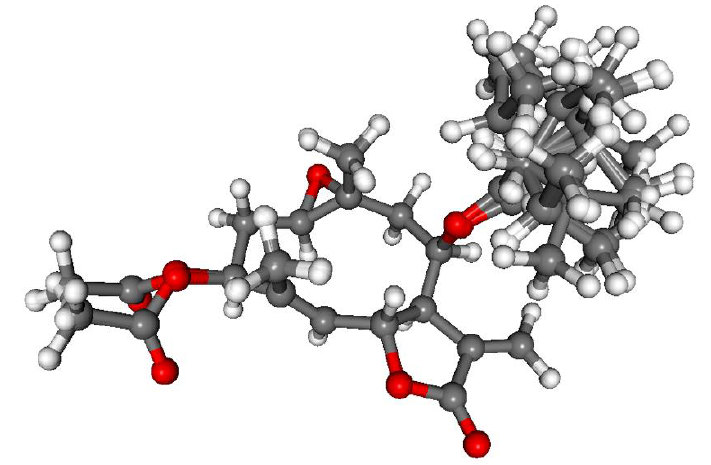
Figure 12. Overlapped geometries of the ten low-energy CAM-B3LYP/TZVP PCM/MeCN conform- ers of (1 R ,3 S ,6 R ,7 R ,8 R ,10 R )- 6